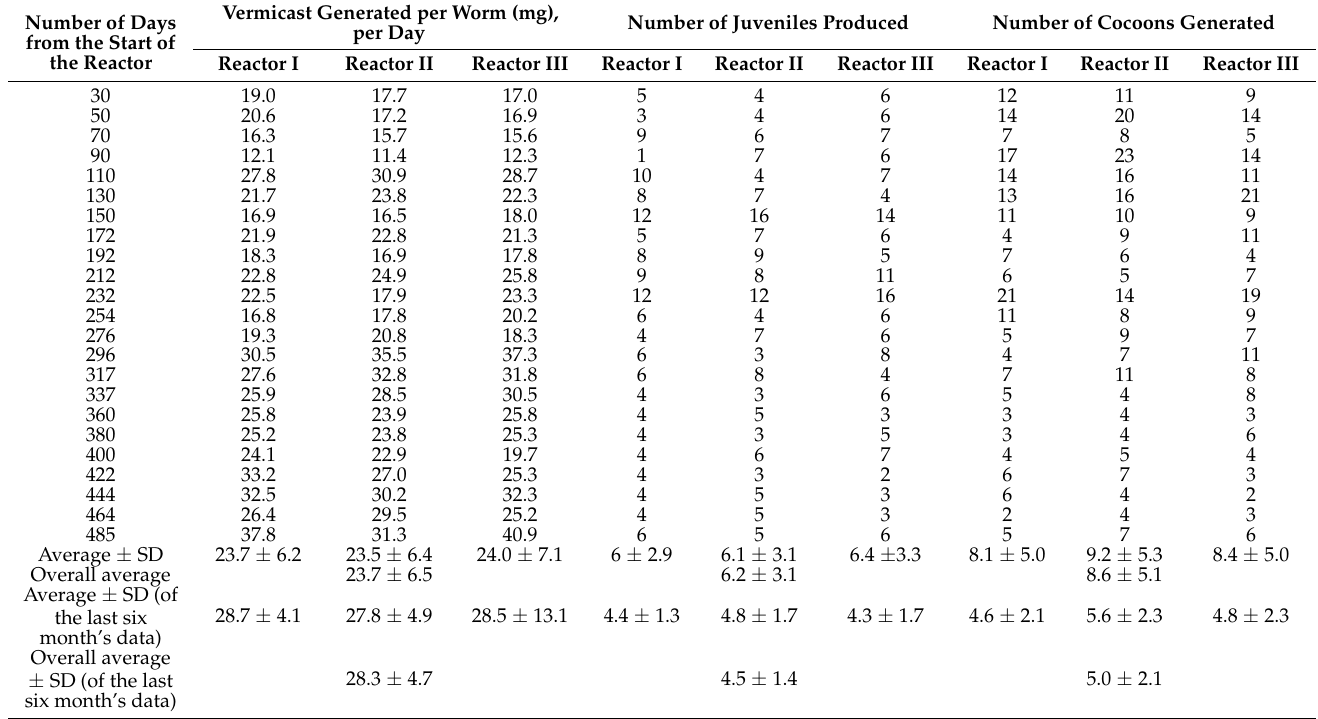
Table 3. Vermicomposting of lantana with 50 adults of E. fetida per kg of feed in pulse-fed